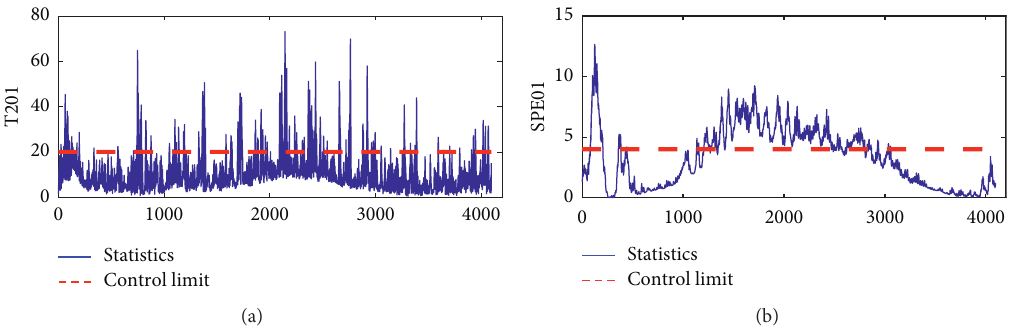
Figure 4: Case Western Reserve University bearing inner ring failure results based on EMD-PCA.